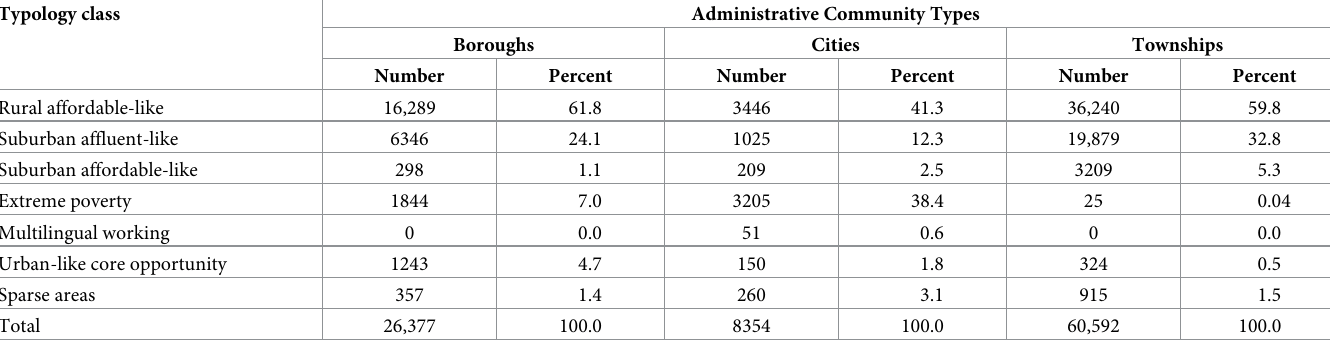
Table 3. Classification of individuals’ residential addresses by administrative community types and SDOH census tract typology. Typology